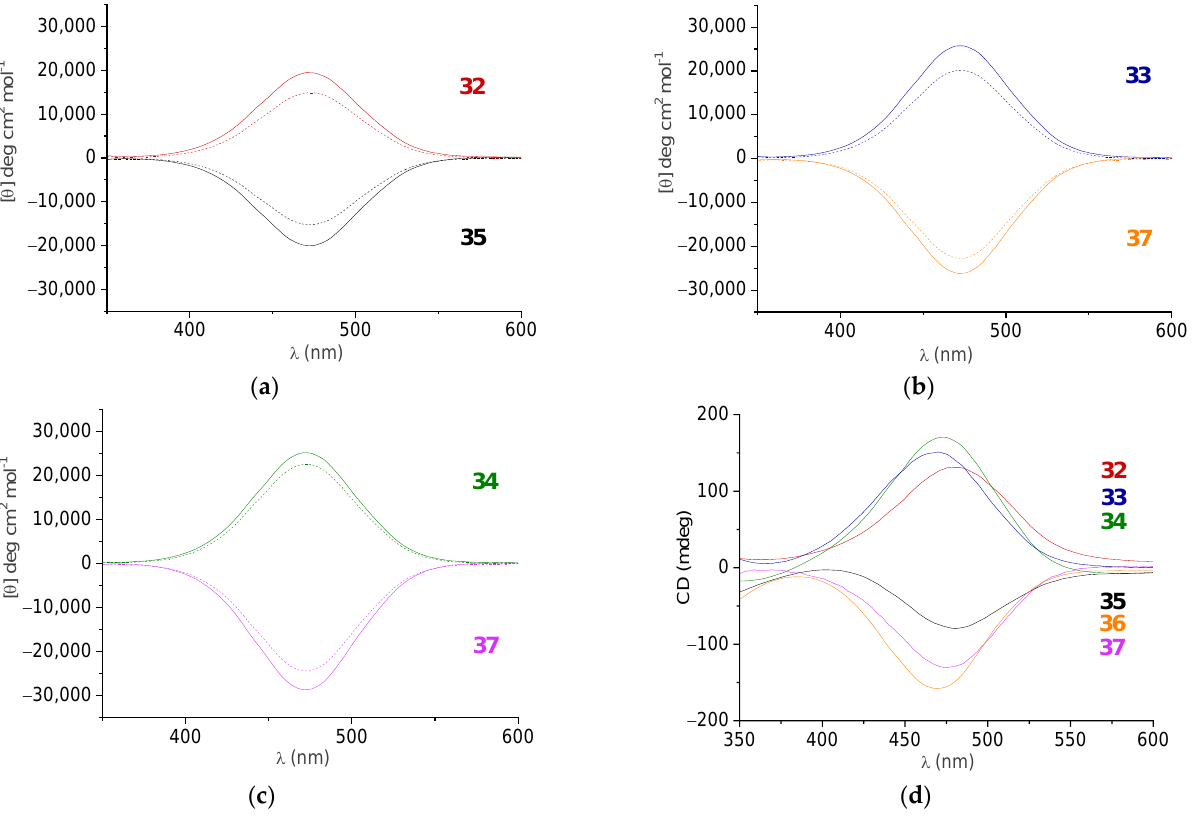
Figure 8. The Cotton effects in chirality-organized ferrocene peptides 32 − 37 ( a – c ) in solution (CH 2 Cl 2 , c = 1 × 10⁻ 3 M, ( ⎯ ) and CH 2 Cl 2 , c = 1 × 10⁻ 3 M containing 20% of DMSO ( – – – )) and ( d ) in solid state (2 mg in 200 mg KBr).